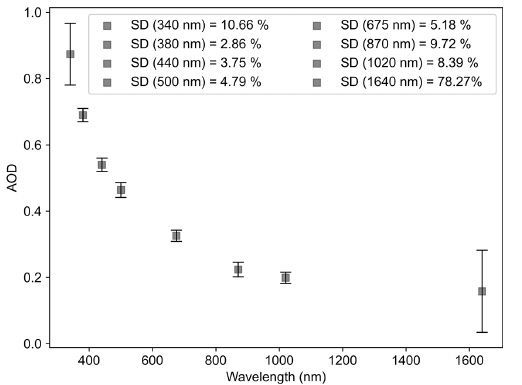
Figure 10. PWV retrievals from EKO using the spectral approach in the 880–1000nm region compared to the synchronous data of CE- 318 in the measuring period (a) , histogram of relative difference among PWV EKO and PWV CIMEL (b) , and the relative difference plotted against PWV CIMEL (c) and solar zenith angle (d) .